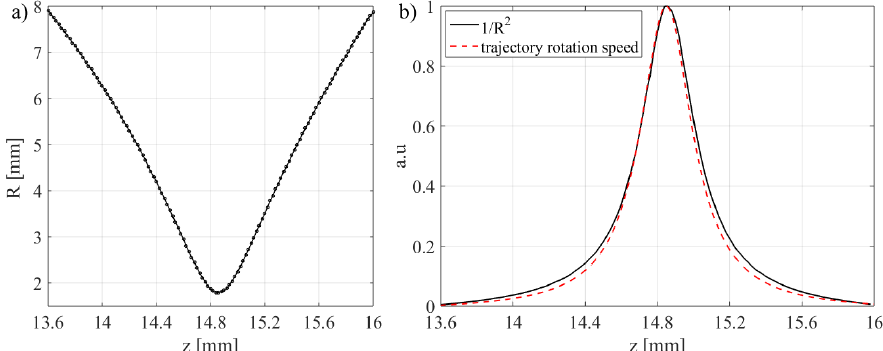
Figure 11. ( a ) The radius R of the focused optical vortex ( m = 1) calculated using Kappa function for the setup in Figure 2b. The radius is minimal at the focal point ( z = 14.86 mm); ( b ) The rotational speed of the vortex trajectory (red) calculated using Equation (24) compared with the inverse square of R (black). The height of the curves was normalized to 1. Parameters used in both calculations: w 0 = 0.4 mm, z G = 600 mm, λ = 630